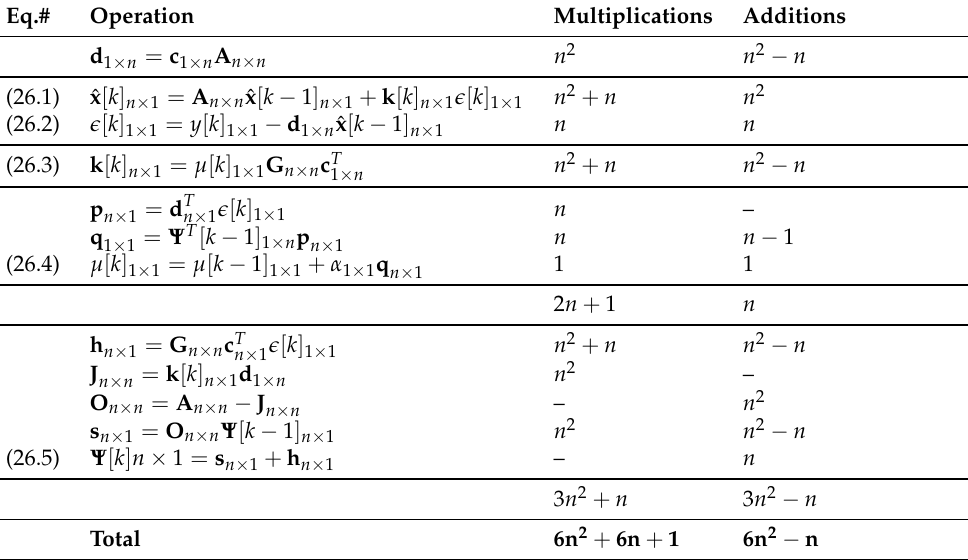
Table 1. Computational complexity of the SSLMSWAM mentioned in Equation